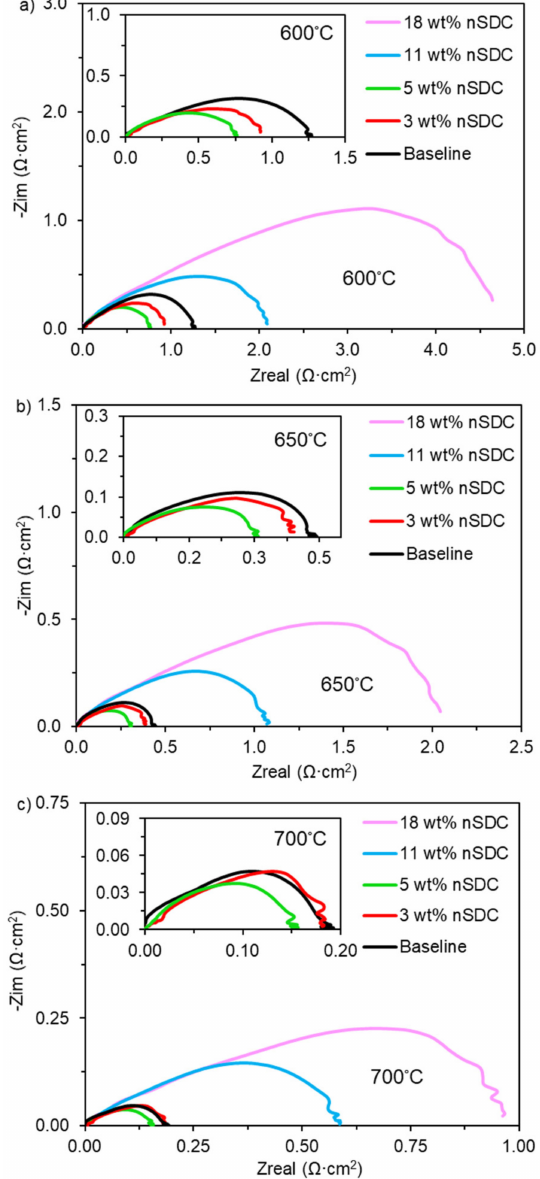
Figure 3. Nyquist plots for LSCF-SDC-nSDC symmetrical cells as a function of nSDC loading at ( a ) 600 ◦ C, ( b ) 650 ◦ C, and ( c ) 700 ◦ C. Similar trends were observed at 650 ◦ C and 700 ◦ C; however, the percent improvement in polarization resistance for 3 wt% and 5 wt% nSDC lessened with increasing temperature and 30% for the 3 wt% and 5 wt% nSDC cells, respectively. At 700 ◦ C, the 3 wt% nSDC cell was nearly the same as the baseline cell and the 5 wt% nSDC showed a 21% reduction, 0.15 Ω · cm